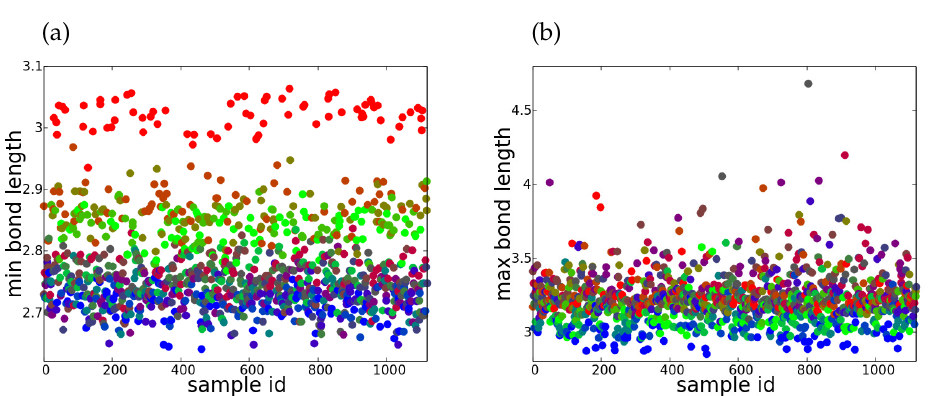
Figure 2. ( a ) Minimum and ( b ) maximum bond length distribution for mixtures of halogens, ex- pressed in [Å], using the RGB encoding: iodine (red), bromide (green) and chlorine